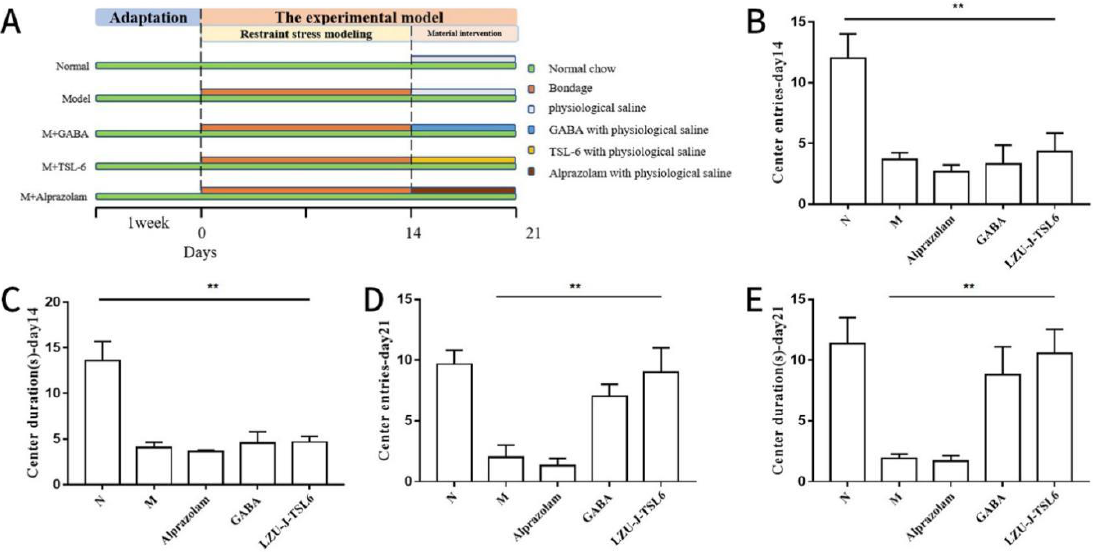
Figure 2. Effect of LZU-J-TSL6 on the behavior in mice with anxiety disorders: Experimental chart of LZU-J-TSL6 alleviating anxiety in mice ( A ). Number of entries ( B ) and time spent in the center ( C ) during open-field exploration (14 day). Number of entries ( D ) and time spent in the center ( E ) during open-field exploration (21 day). Bars show the mean ± SD ( n = 5 mice per group) ** p < 0.01.